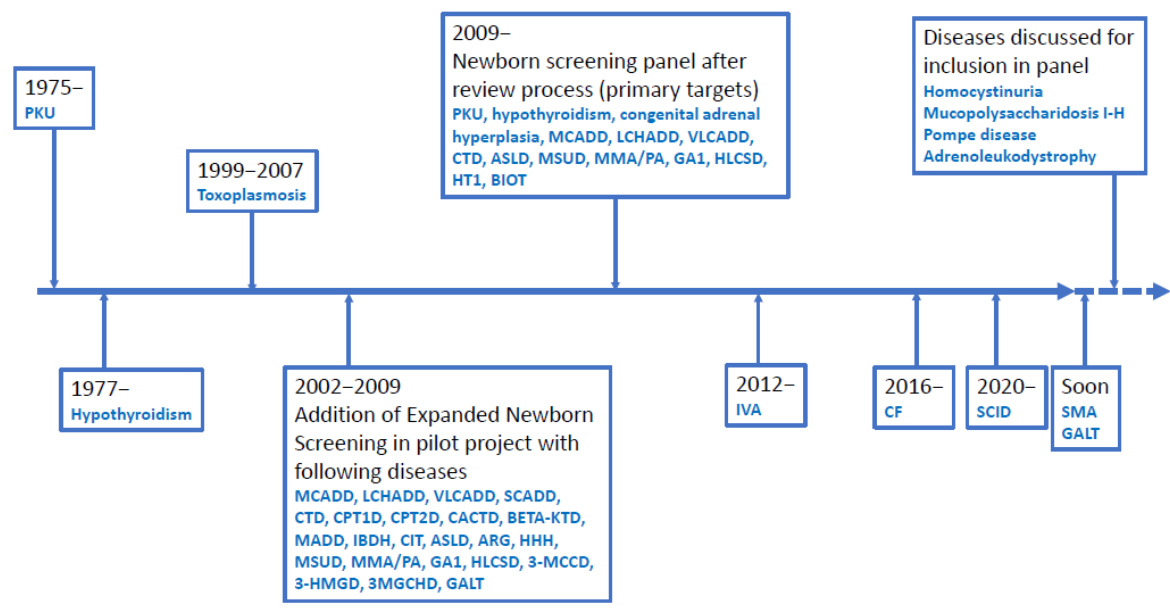
Figure 1. Timeline for Danish Newborn Screening. Disease abbreviations are shown in the list of